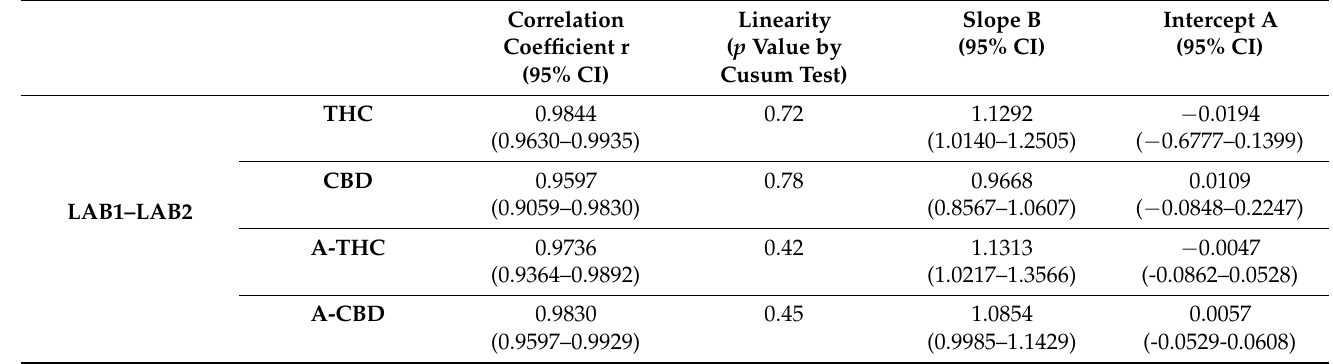
Table 3. Results of the Passing Bablok method